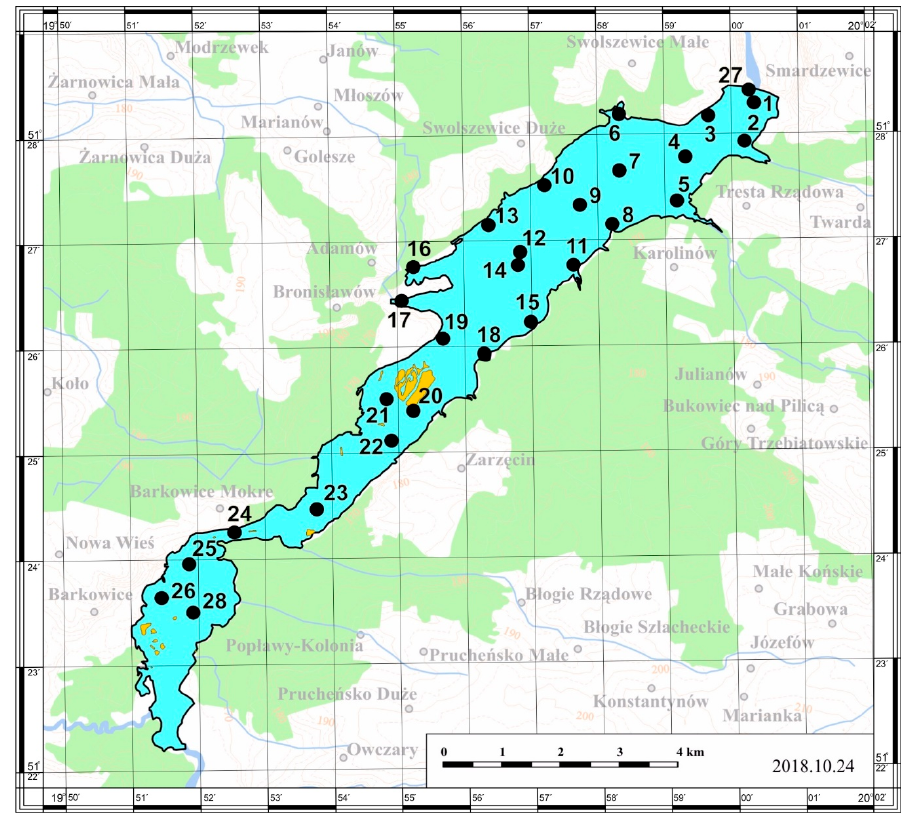
Figure 4. Sampling point locations in the Sulejów Dam Reservoir.